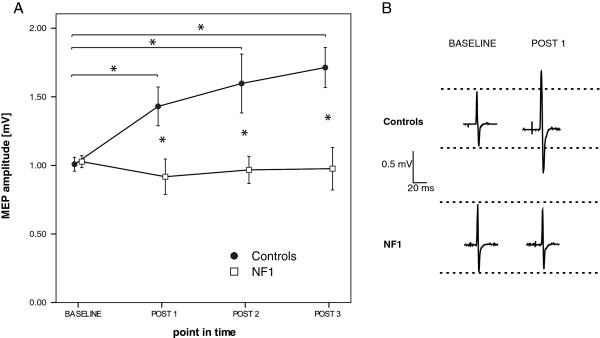
Synaptic plasticity in patients with NF1 and controls. A) Depicted is the time course of MEP amplitudes after PAS in healthy controls and patients with NF1. PAS led to a significant MEP increase only in the control group. Abscissa pictures point in time and ordinate mean MEP amplitude. Asterisks indicate significant differences between two groups or points in time (p < 0.05, unpaired t test), error bars represent ± standard error of the mean. B) MEP amplitudes from two representative subjects of controls and NF1before and at POST 1 after PAS. Shown are averages of 20 MEP trials in each case.